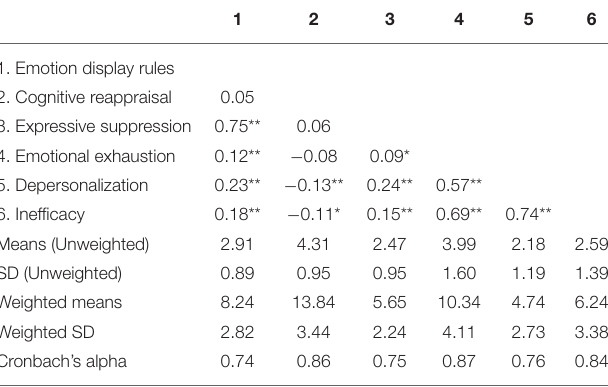
TABLE 1 | Zero-order correlations of weighted latent variables in the